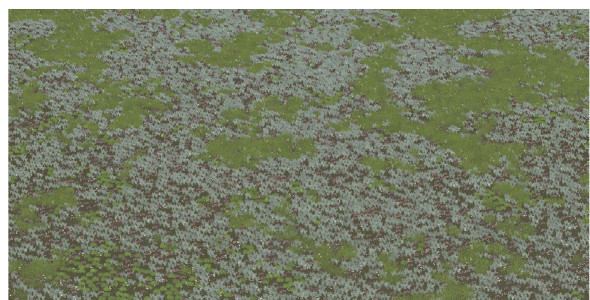
Figure 19: Gaps appear in the plant distribution when viewing the visualization in global view.